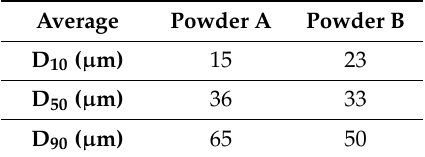
Table 2. Summary of particle size data for both powder A and